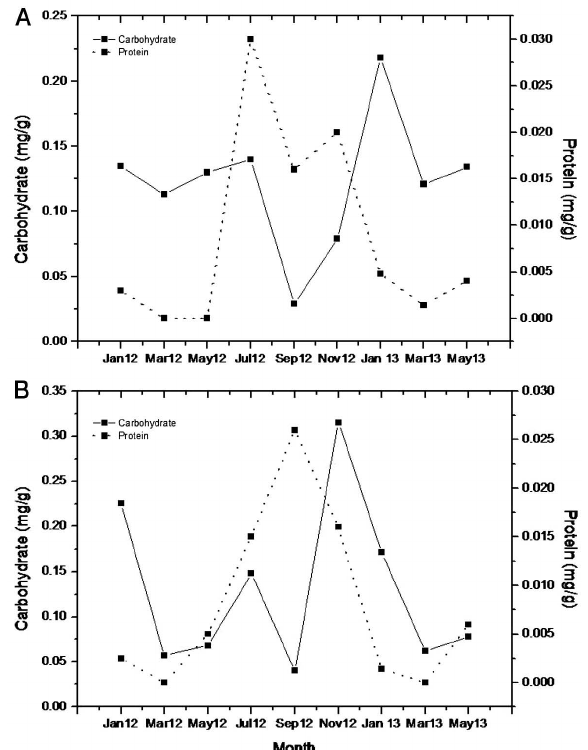
Fig. 4. – Seasonal variations of sedimentary carbohydrates (CHO) and proteins (PRT) at Site 1 (A), Payyannur (PNR) and Site 2 (B), Panambur (PNBR).